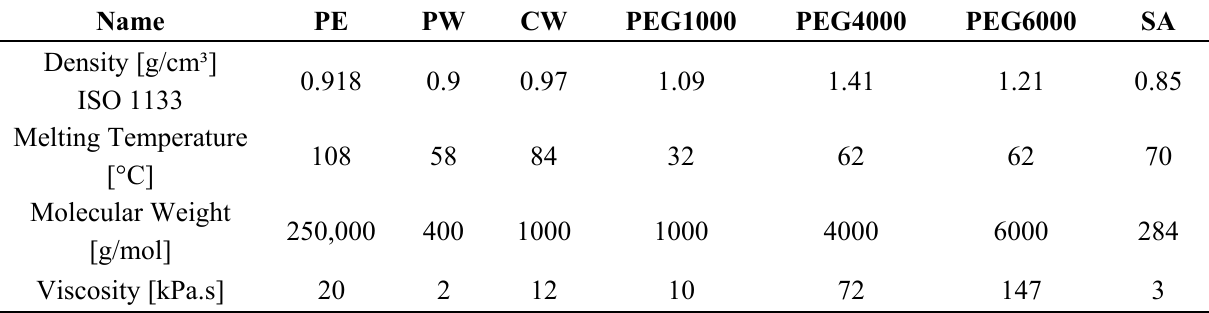
Table 5. Characteristic properties of the binder